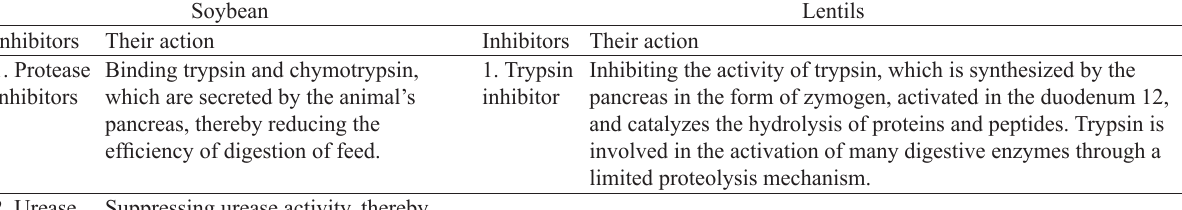
Table 1 Digestive enzyme inhibitors in legumes Soybean Lentils Inhibitors